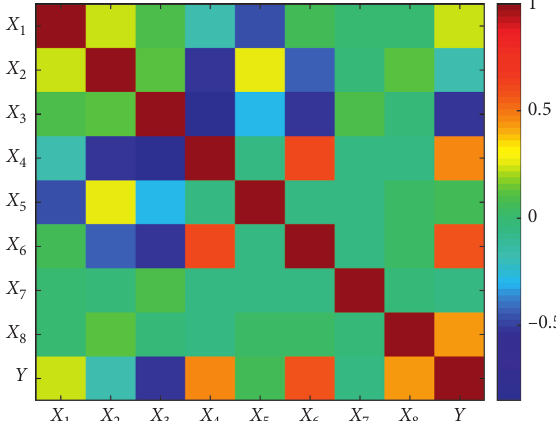
Figure 2: Multicorrelation graph of input and output variables used in this